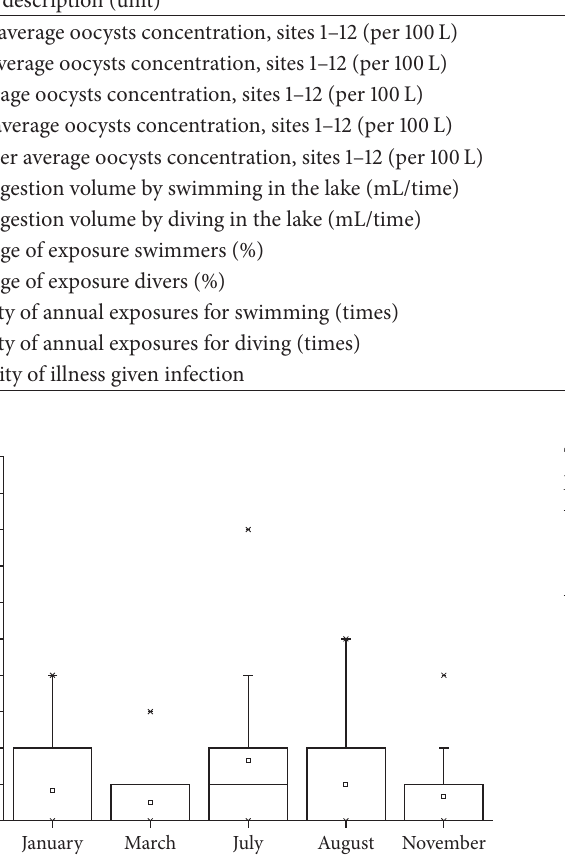
Figure 2: Cryptosporidium oocysts in water samples.